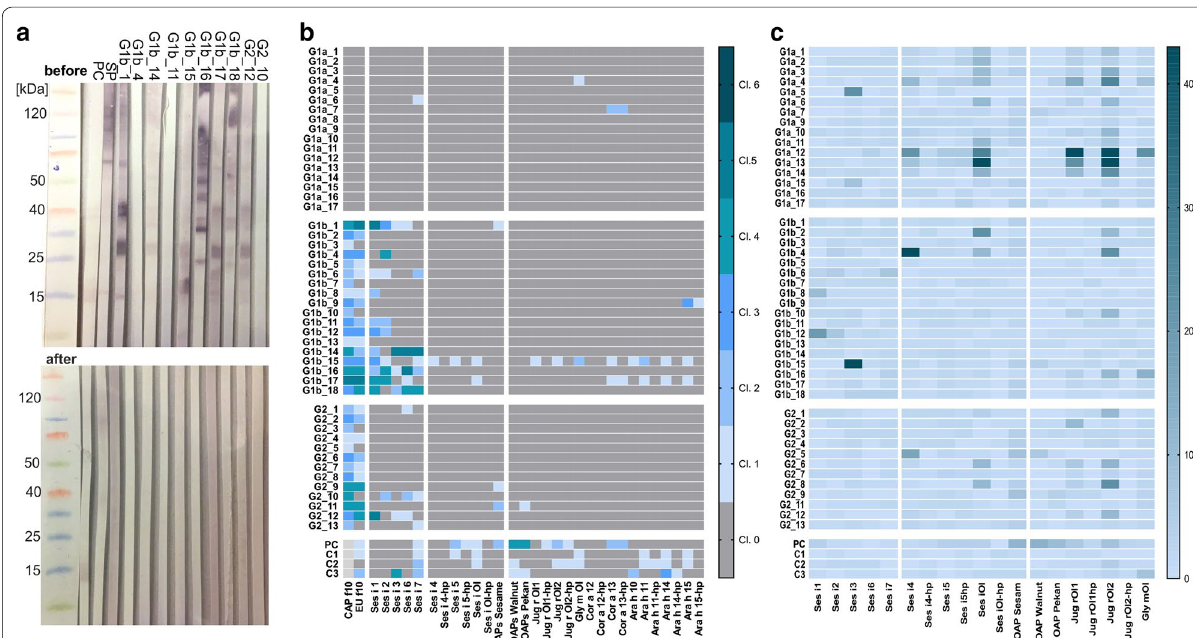
Fig. 1 Western blot analysis of native sesame OAPs fraction to confirm the absence of seed storage protein traces ( a ) and the specific IgE ( b ) and IgG sensitisation pattern ( c ) of all included patients. a Western‑Blot analysis of an intermediate purification step (before HIC) and of the final OAPs fraction (after HIC) with sera containing sIgE to sesame seed storage proteins and oleosins. Samples were separated by SDS‑PAGE using a 4–12% Bis–Tris gel and blotted onto a nitrocellulose membrane. Bound IgE were detected by anti‑human IgE antibodies conjugate labelled with alkaline phosphatase; PC is a oleosin‑positive serum, SP is a sesame seed storage positive serum not used in this study, sera G1b_1, 4, 14, 11, 15–18, G2_12 and 10 are sera with specific IgE to sesame seed storage proteins and partly with slightly elevated sIgE levels to sesame oleosins. b IgE sensitisation pattern to sesame extract from ImmunoCAP and EUROLINE, sesame components and oleosins from sesame, walnut, soy, hazelnut and peanut expressed as EAST (Enzyme‑Allergo‑Sorbent Test classification)‑classes and sorted by severity of symptoms to sesame, light grey: not determined. c IgG‑sensitisation pattern to sesame components and oleosins from sesame, walnut, pecan and soy expressed as EUROLINE (EL)‑intensities and sorted by severity of symptoms to sesame. G1a sesame allergic patients without detectable sIgE sensitisation, G1b sesame allergic patients with sIgE sensitisation, G2 sesame tolerant patients with sIgE sensitisation, PC positive control selected by sIgE to sesame oleosins, C1 ‑ 3 positive controls selected by sIgE to peanut